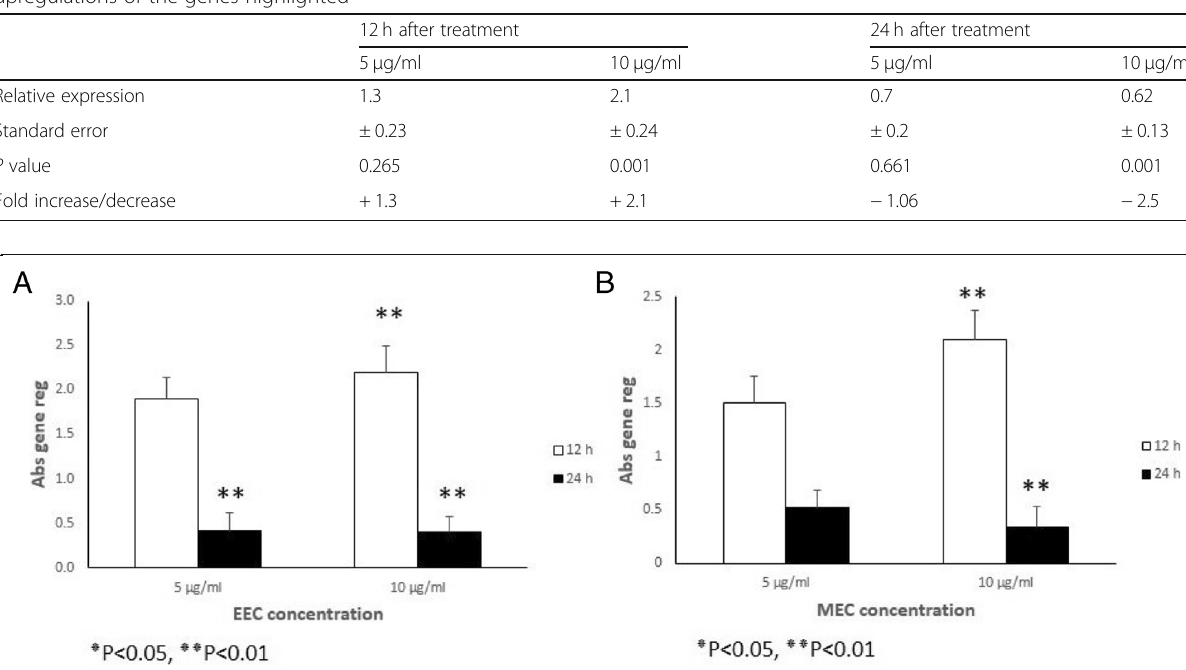
Fig. 3 Relative expression of bFGF gene in the MEFs that were treated with various concentrations of ethanol ( a ) and methanol ( b ) extracts of Calendula at different time intervals treatment (12 and 24h). All comparisons were made compared to the control group. P <0.05, P <0.01. Abs gene reg: